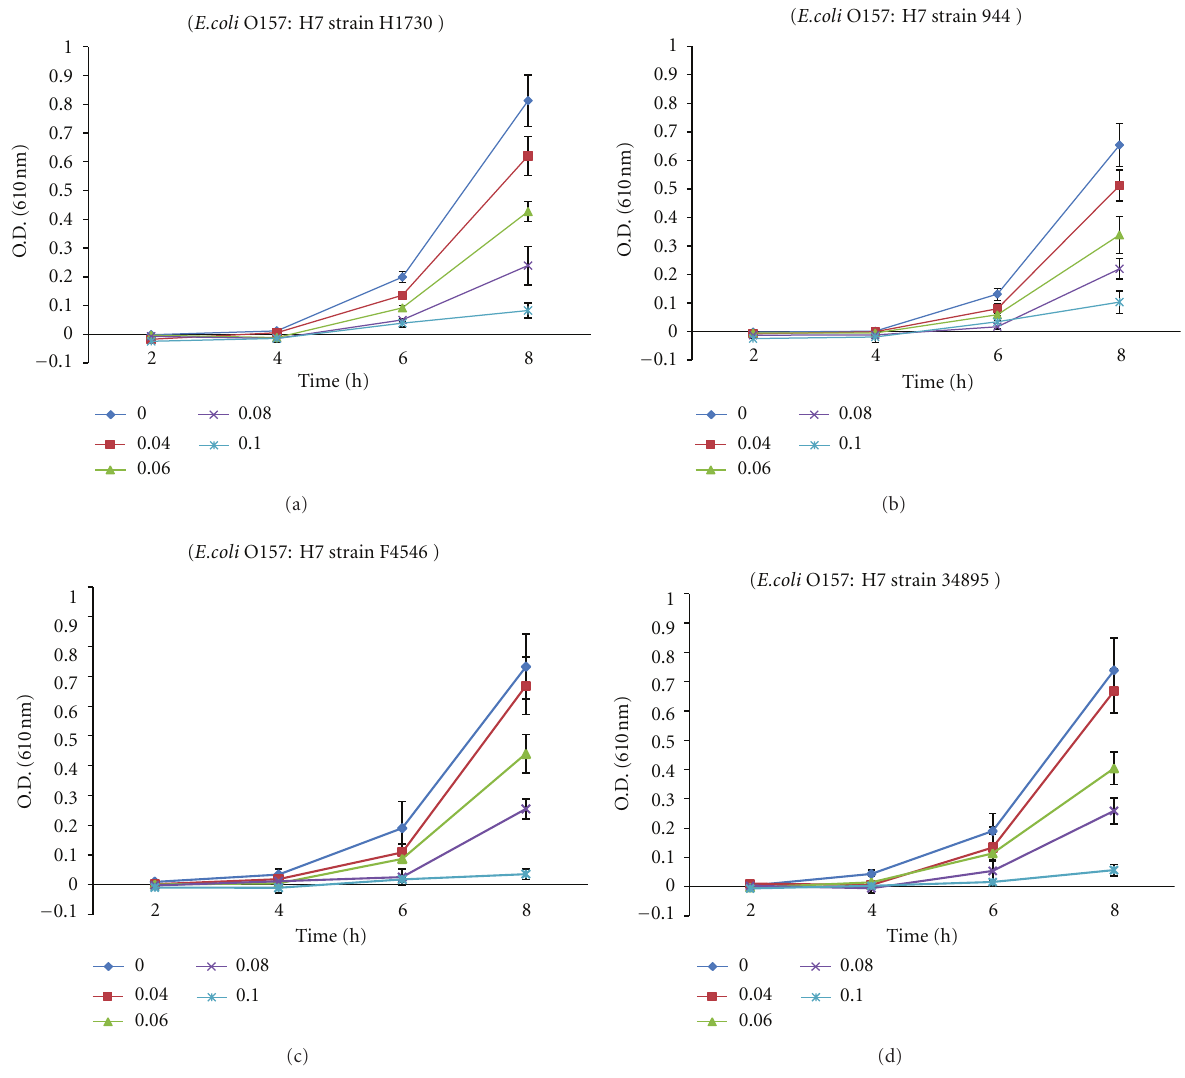
Figure 1: Bacterial growth curve of E. coli O157:H7 strains in the present of xoconostle extract at di ff erent concentrations % (v/v) in BHI broth during 8h of incubation at 37 ◦ C measured by turbidity (optical density 610 nm). Data points are the average of 3 replicates with standard error.